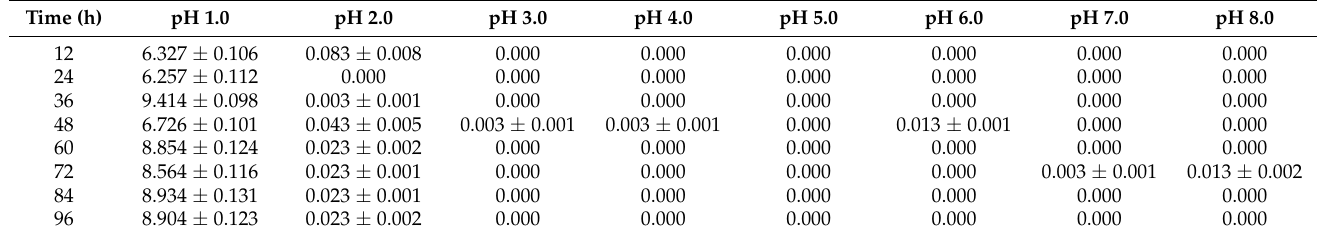
Table 3. Total iron concentration released from MRCM in solutions with different pH